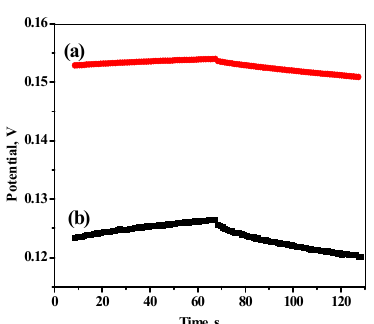
Figure 7. Potential stability of the applied sensor ( a ) with and ( b ) without MWCNT as a solid contact material.